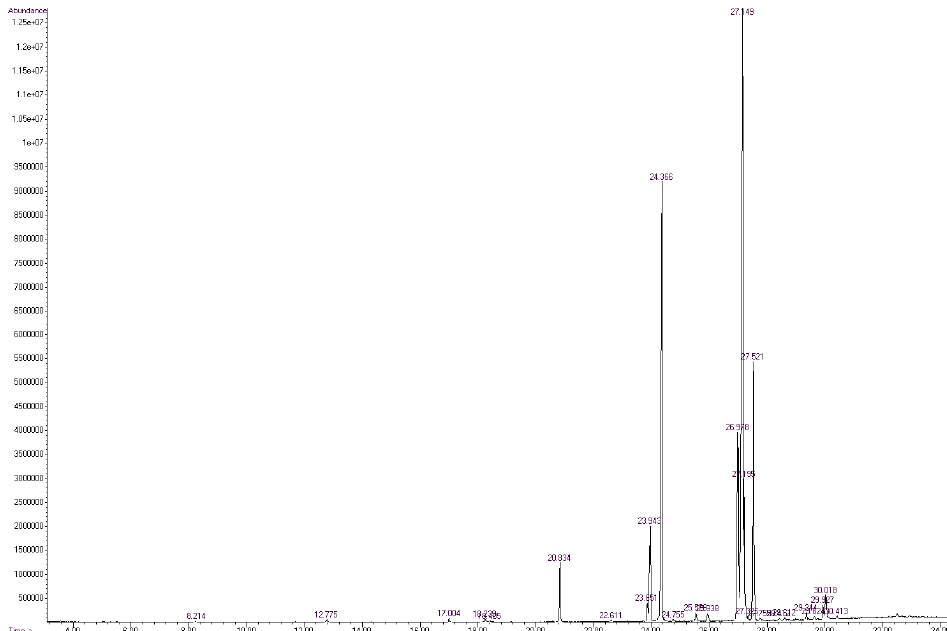
Figure 4. Gas chromatogram from the GC-MS analysis of the derivatized layer 1 of Mangalitza hard fat (thermally processed sample, code P1). All other GC chromatograms for the thermally processed samples are presented in the Supplementary material file (Figures S2, S5, S6, S9, and S10).